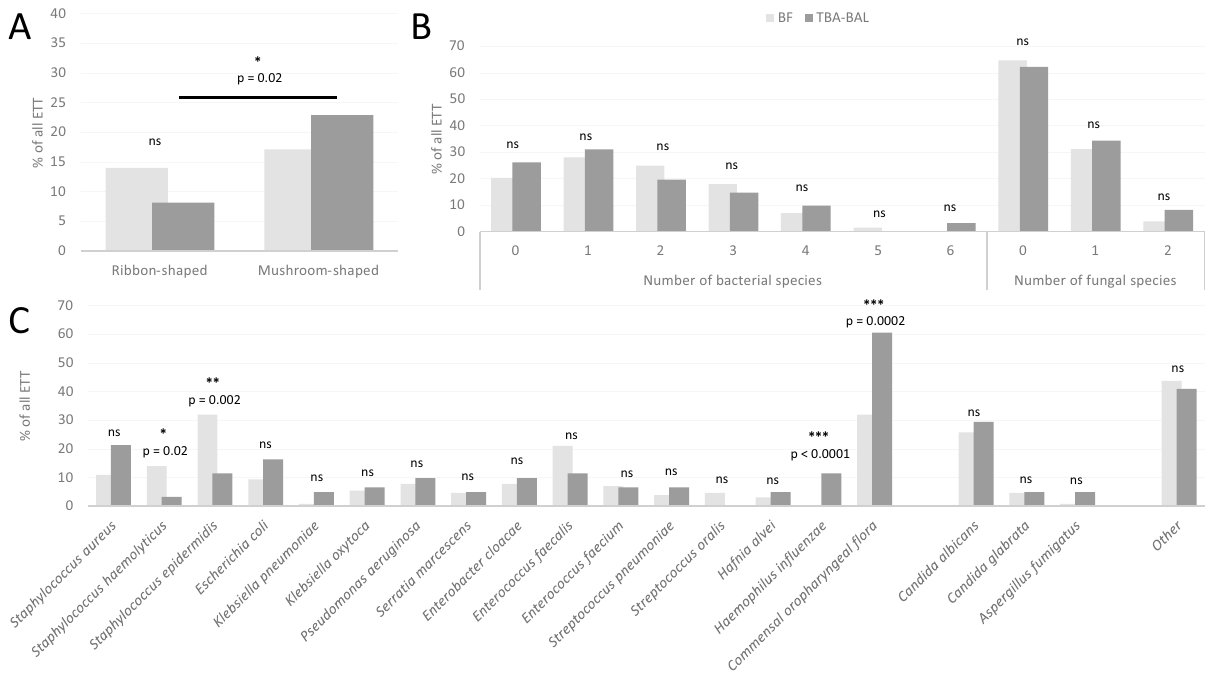
Figure 4. Microbiological characterization of ETT-deposited BF in comparison to respiratory samples (TBA-BAL). ( A ) compared percentage of ETT retrieving both bacterial and fungal species between ETT- deposited BF and respiratory samples; ( B ) compared number of both bacterial and fungal species between ETT-deposited BF and respiratory samples ; ( C ) compared distribution of both bacterial and fungal species between ETT-deposited BF and respiratory samples. BAL bronchoalveolar lavage, BF biofilm, ETT endotracheal tube, ns not significant, TBA tracheobronchial aspirate. Other (microbiological species retrieved < 5%) : Candida kefyr , Candida lusitaniae , Candida parapsilosis , Candida tropicalis , Citrobacter freundii, Enterobacter cancerogenus, Enterococcus durans, Klebsiella aerogenes , Klebsiella variicola , Lactobacillus gasseri, Lactobacillus paracasei, Lactobacillus rhamnosus , Morganella morganii, Neisseria mucosa, Propionibacterium acnes, Proteus mirabilis, Pseudomonas oryzihabitans , Raoultella ornithinolytica, Serratia rubidae, Staphylococcus hominis, Stenotrophomonas